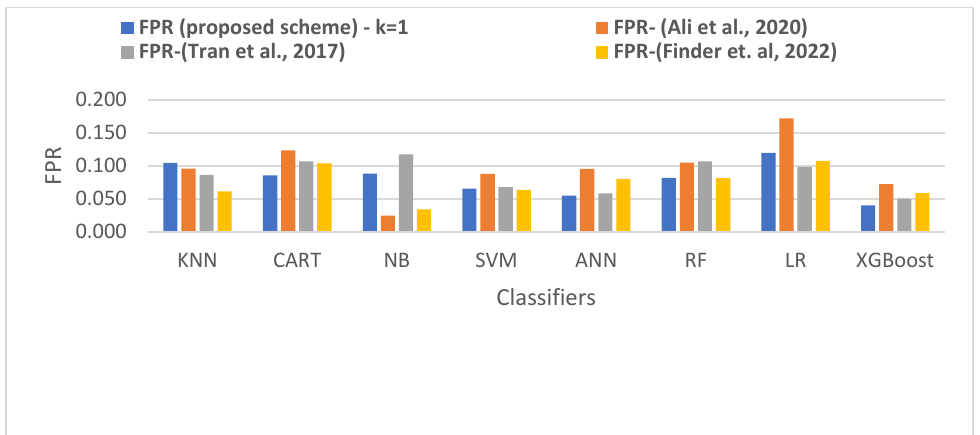
Figure 8. The comparison of the F -measure between the proposed DIEBD-based scheme and the related work-based schemes.